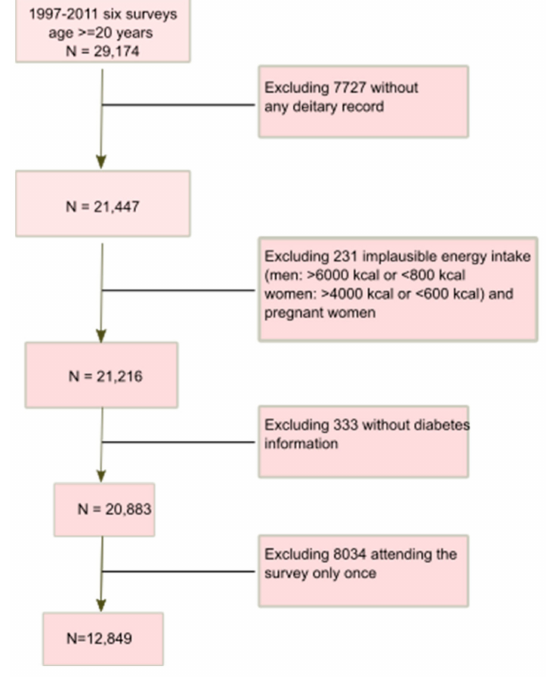
Figure 1. Sample flowchart of participants attending CHNS 1997 −